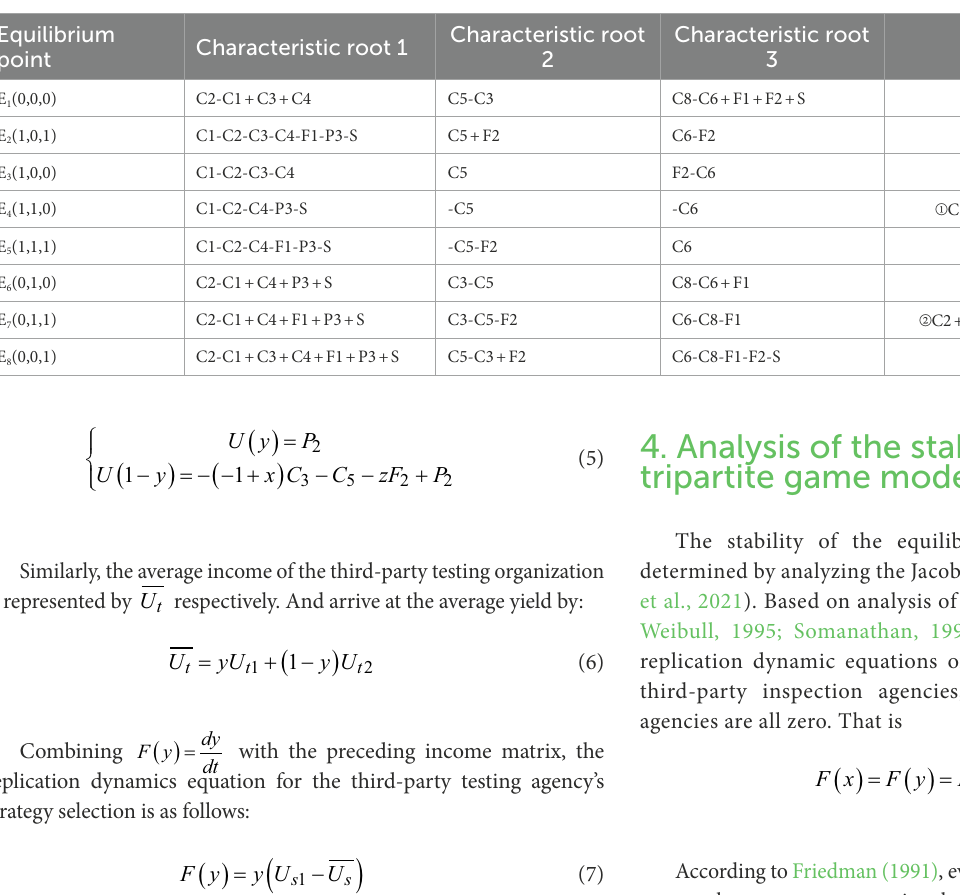
Characteristic root 2